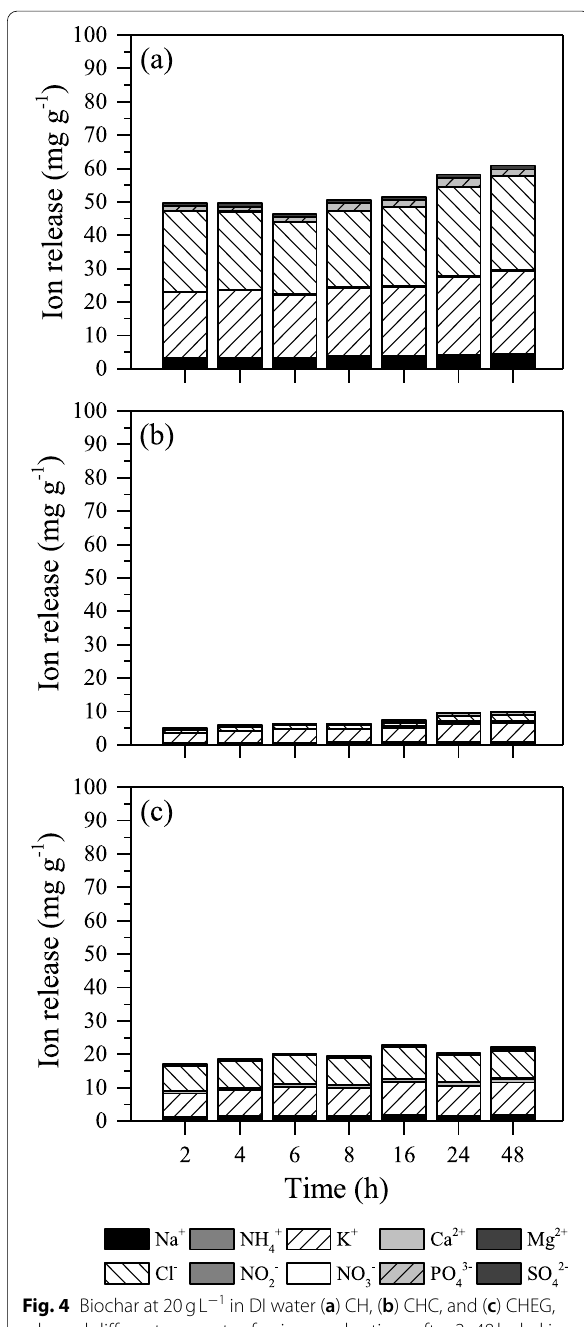
Fig. 4 Biochar at 20 g L − 1 in DI water ( a ) CH, ( b ) CHC, and ( c ) CHEG, released different amounts of anions and cations after 2–48 h shaking at 120 rpm and temperature of 30